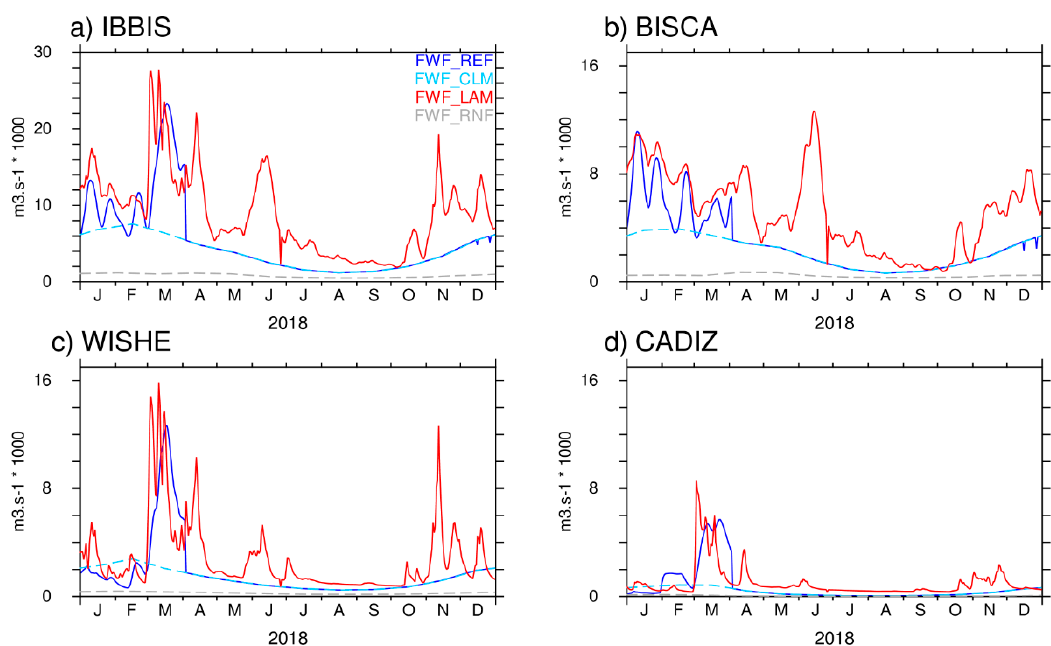
Figure 3. Average daily freshwater discharges imposed as forcing in different IBI sensitivity runs in ( a ) IBBIS, ( b ) BISCA, ( c ) WISHE and ( d ) CADIZ areas, in 2018. The freshwater forcing FWF_REF, FWF_LAM, FWF_CLM and FWF_CRF data sources are respectively depicted in blue, red, dashed blue and grey. Table 4. IBI model scenarios: Overview of model runs with each specific treatment of river and coastal freshwater inputs. IBI